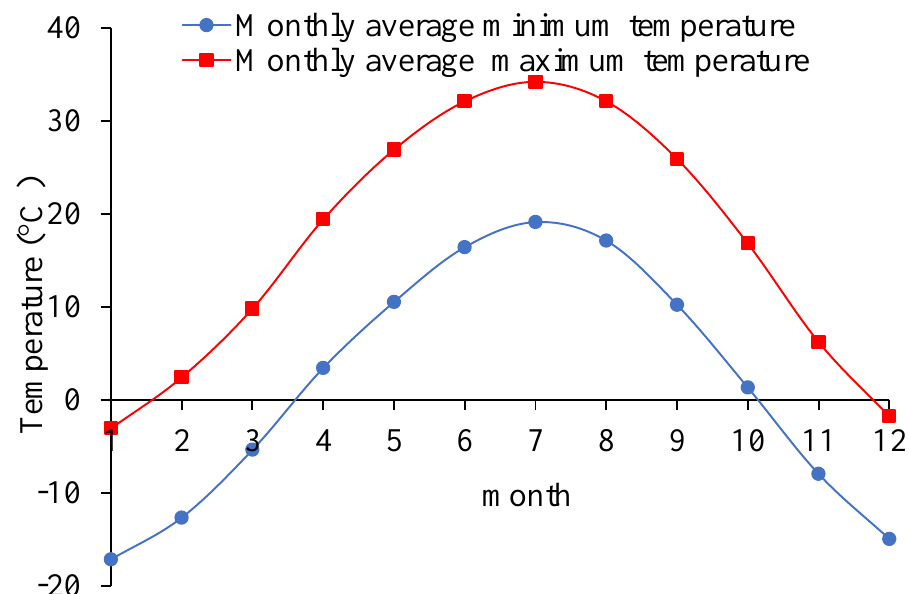
Figure 3. The maximum temperature and the minimum temperature each month.